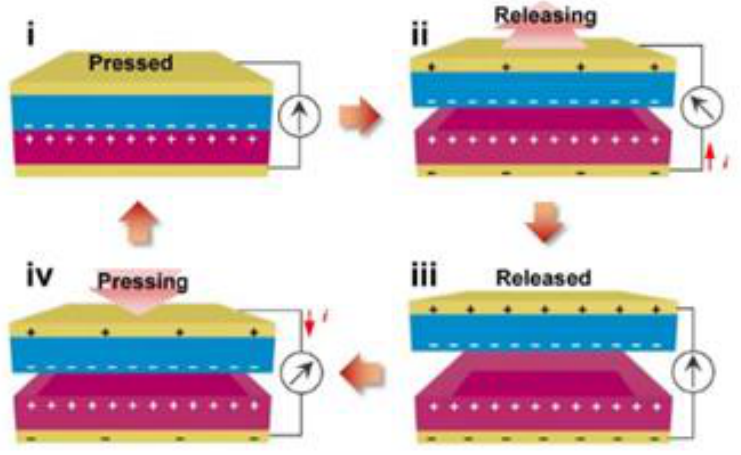
Figure 4. Scheme representing the general functioning of a TENG. [110], ( i ) Pressed ( ii ) Releasing ( iii ) Released ( iv ) Pressing.